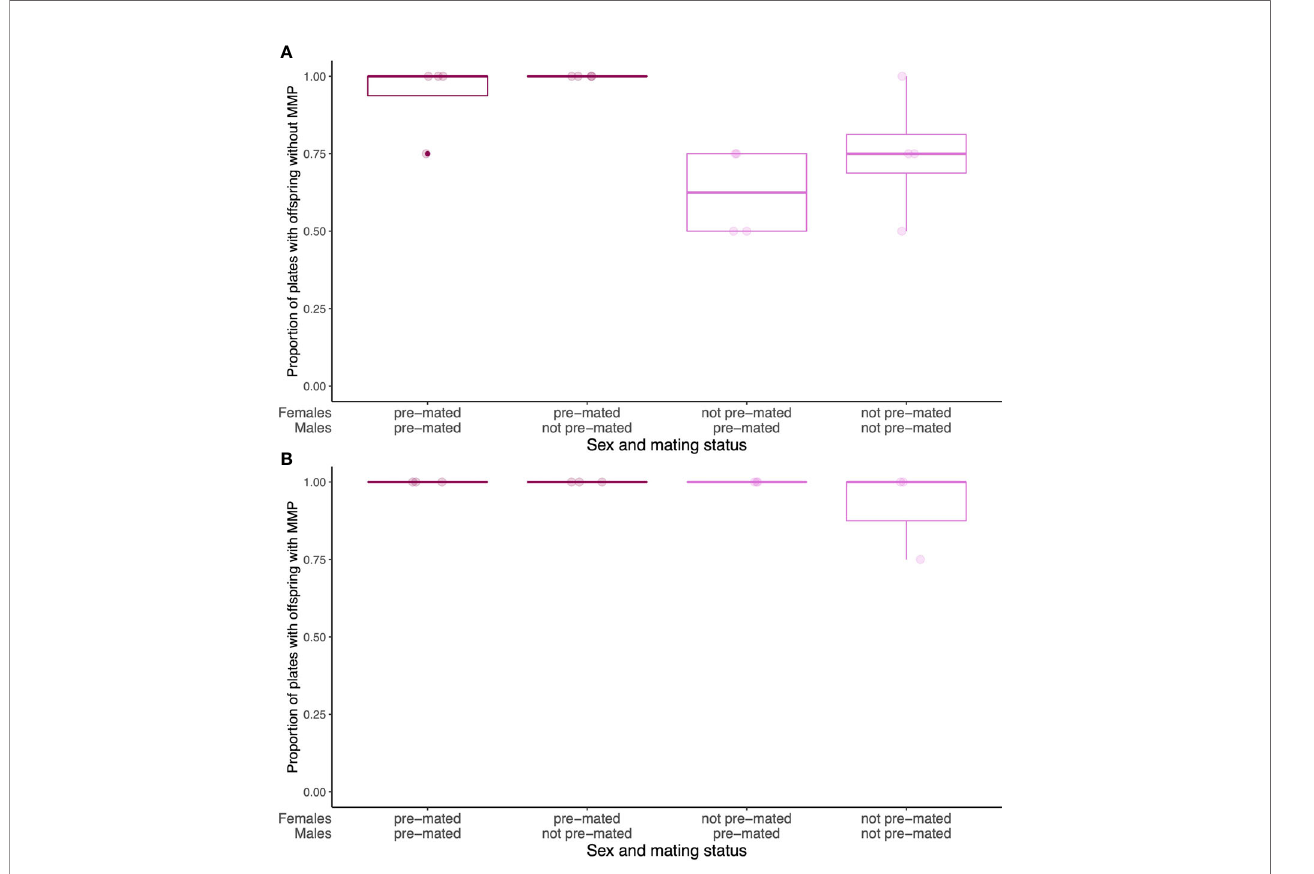
FIGURE 3 | Differences in timing of offspring production during pathogen infection without (A) and with (B) MMP (A) . During pathogen infection but without MMP, there are fewer plates with offspring, despite the presence of males. (B) During pathogen infection, but with MMP, all plates with pre-mated and not pre-mated females are producing offspring. Boxplots represent three or four technical replicates with 25 females and 25 males on each